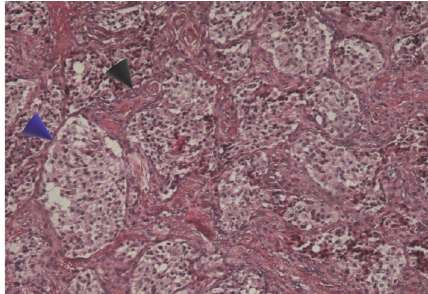
Figure8:HistopathologicalappearanceofCBP(15-year-oldteenage boy) showing “zellballen” growth pattern of paragangliomas (blue arrow). Prominent fibrovascular stroma separates nests (black arrow).